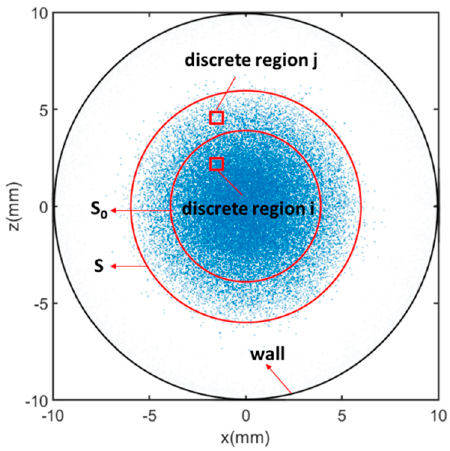
Figure 2. The particle distribution on one of the deposition surfaces at a certain substrate distance.